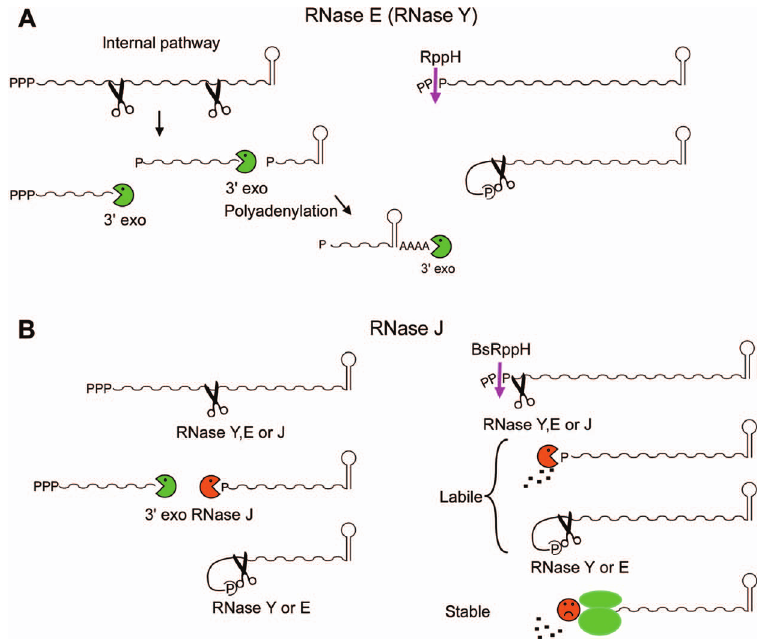
Figure 4 Bacterial mRNA degradation